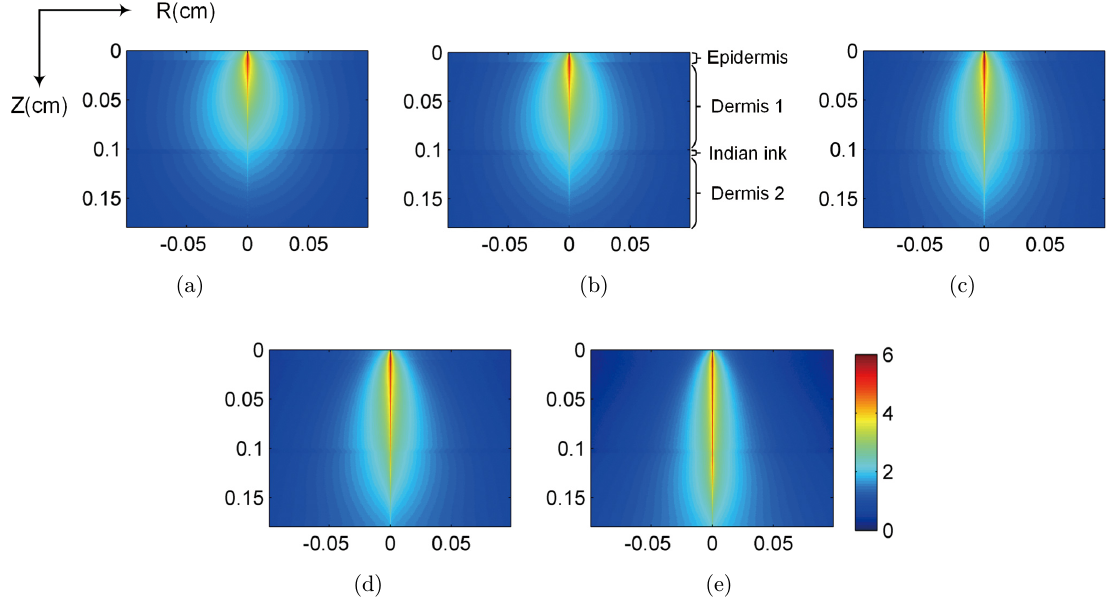
Fig. 3. Distribution of light °ux in the tattoo model with di®erent degree of skin optical clearing simulated by MC method. (a) initial state; (b) – (e) skin with optical clearing e±cacy of 20%, 40%, 60% and 80%, respectively. The tattoo model is of four layers: epidermis, dermis 1, Indian ink layer and dermis 2. All ¯gures have the same color